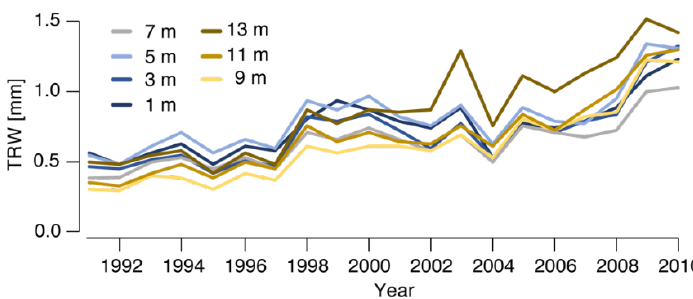
Figure 6. Longitudinal TRW variability. TRW disc mean curves (DMCs) at tree heights from 1 to 13 m.